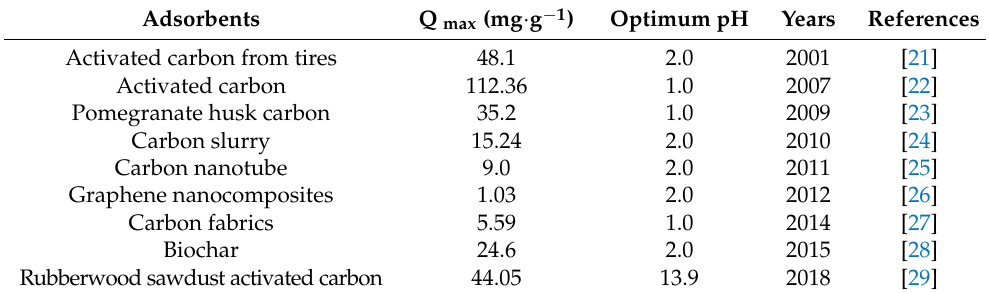
Table 1. Comparison of adsorption capacity for Cr(VI) ions by typical carbon material.